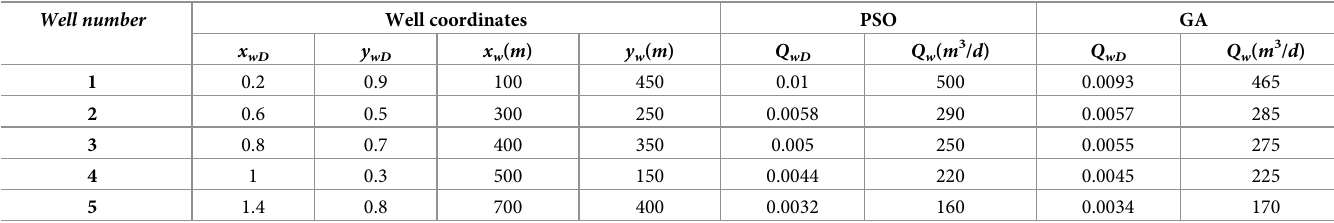
Table 4. Well positions and the calculated extraction rates of wells in the quantity management scenario. Well number Well